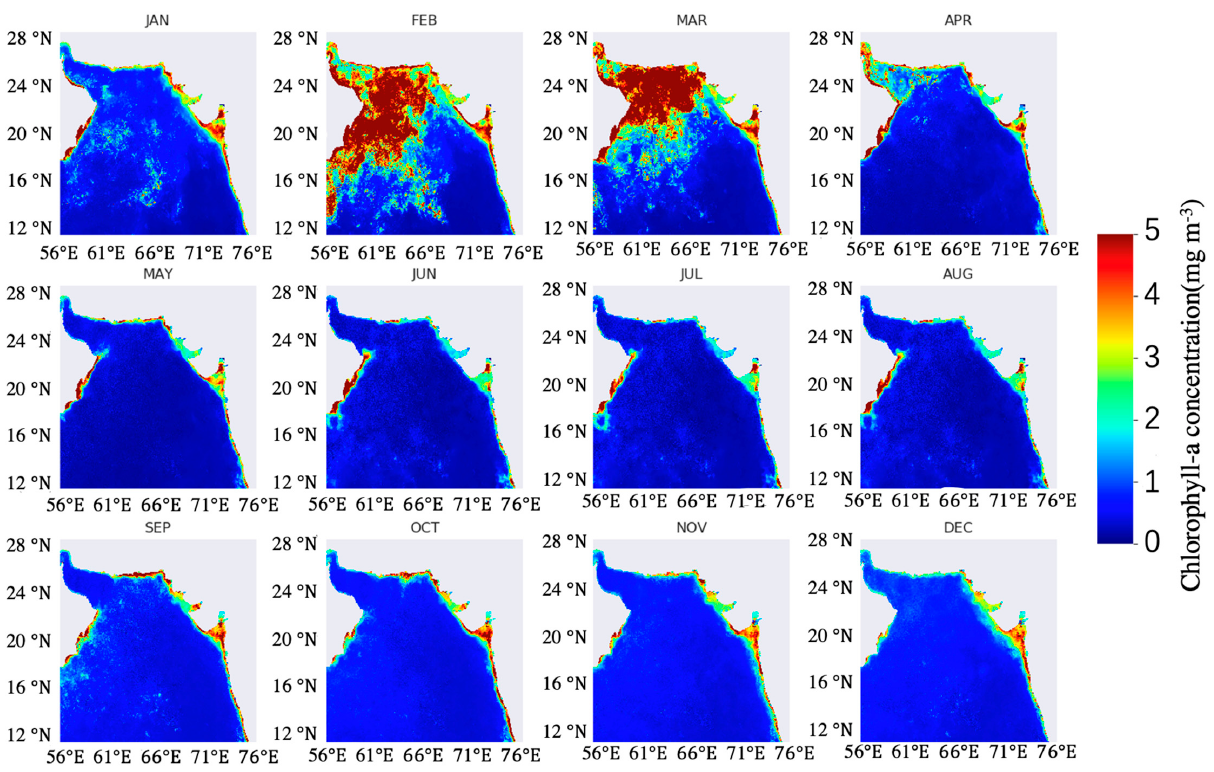
Figure 11. Monthly interpolation results for Chl–a with the DINCAE–BME from January to Decem- ber 2020.